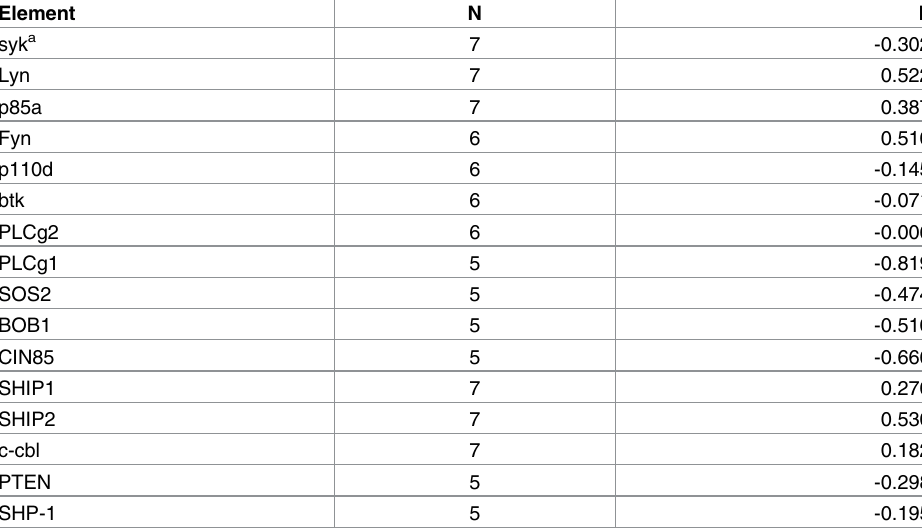
Table 3. Pearson R for each element vs. FceRI; all p > 0.05.